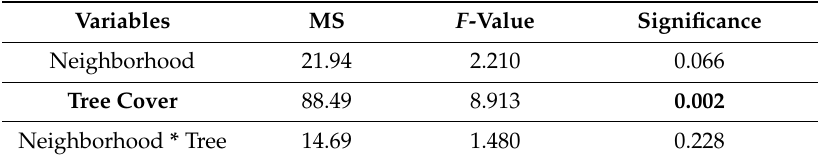
Table 6. Two-way ANOVA for mean temperature at 1500 LDT for the entire warm season based on neighborhood classification and tree density, including mean-square error (MS), F value, and significance. Bold variables are significant ( p < 0.05).